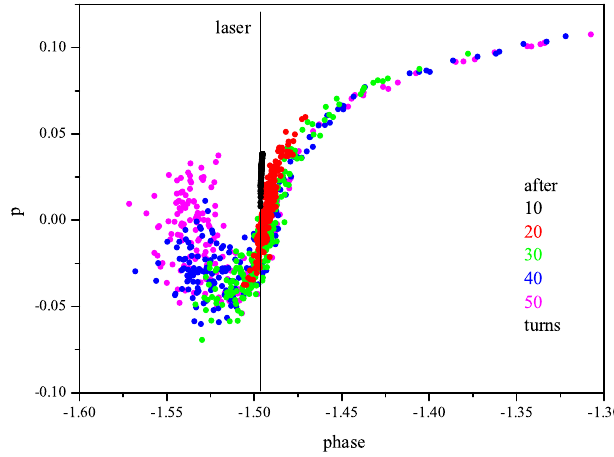
FIG. 9. (Color) Snapshots of macroparticle distributions during the interaction with an intense laser pulse in the rf-phase ma- nipulation mode, for the ILC YAG Compton ring (phase origin at zero of the plateau rf phase).